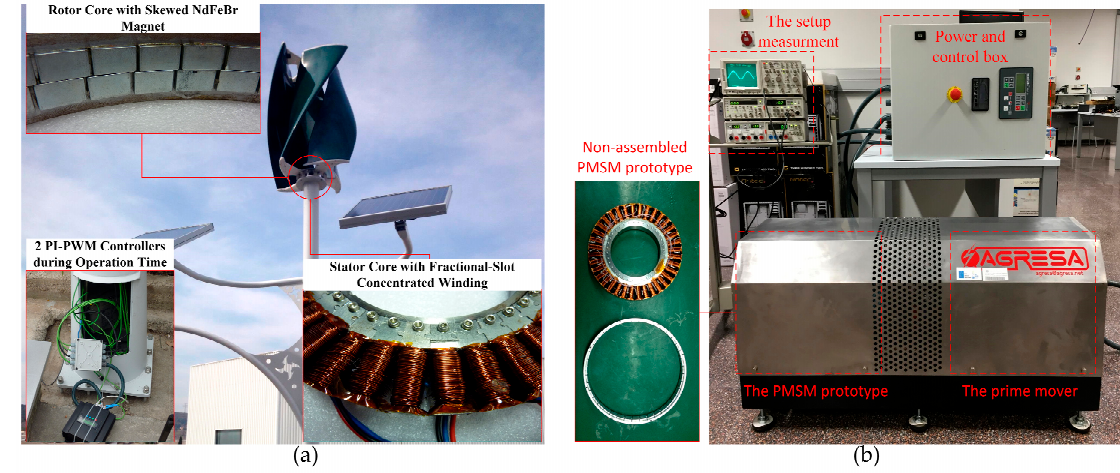
Figure 8 . Experimental investigation. ( a ) the proposed PMSM with non-assembled parts under operation; ( b ) experimental setup .